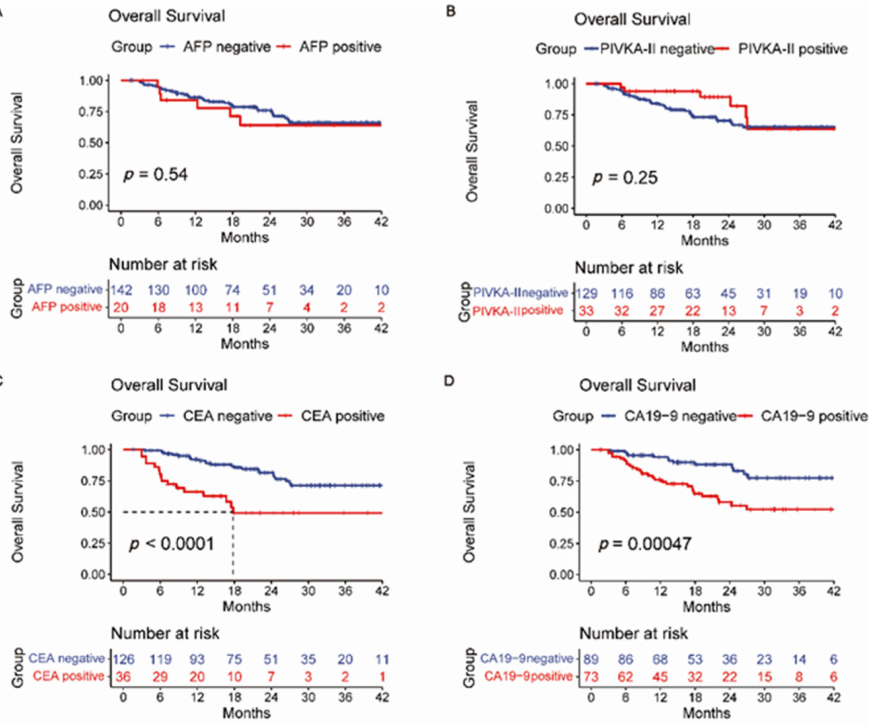
Figure 1. Overall survival (OS) curves of grouped intrahepatic cholangiocarcinoma patients based on ( A ) AFP, ( B ) PIVKA-II, ( C ) CEA, and ( D )